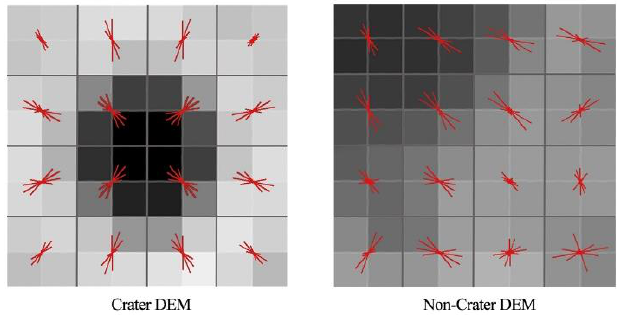
Figure 1. Illustration of the extracted HOG features for a crater DEM and a non-crater DEM.